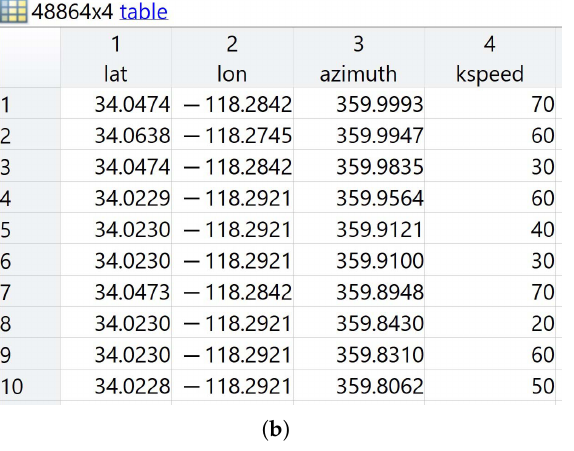
Figure 5. Snapshots of LA small BSs and vehicles tables after data curation step. ( a ) Snapshot of LA small BSs table. ( b ) Snapshot of LA vehicles table.